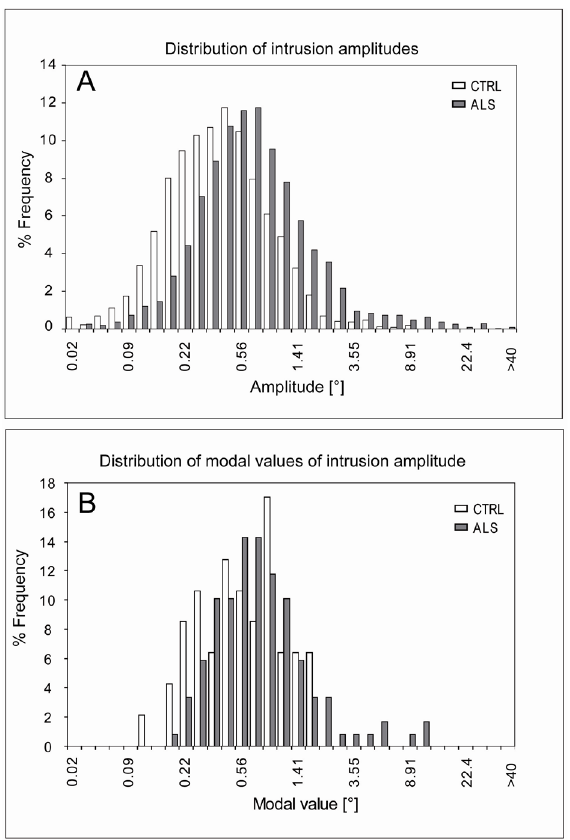
Fig. 2. Frequency distribution of intrusion amplitudes in ALS and controls (CTRL). A , amplitudes of intrusions forming BAF patterns, pooled data from all participants; N= 5132 (ALS) and N=2206 (CTRL). B , modal values of subjects’ individual amplitude distributions (intrusions belonging to STC and BAF patterns pooled); N=47 (CTRL) and N=119 (ALS). Note logarithmic scaling of bins in both